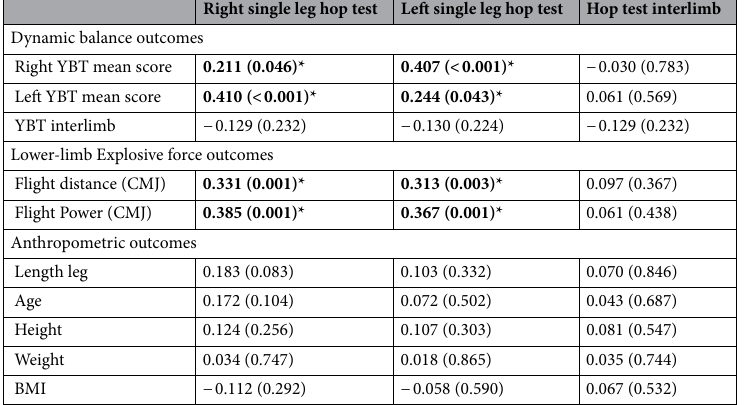
Table 2. Correlation study for the total sample of the study (n = 90). Pearson correlation ( p values). Significant values are in bold. YBT: Y Balance test; CMJ: Counter Movement Jump, BMI: Body Mass Index. * indicates p vales < 0.05.